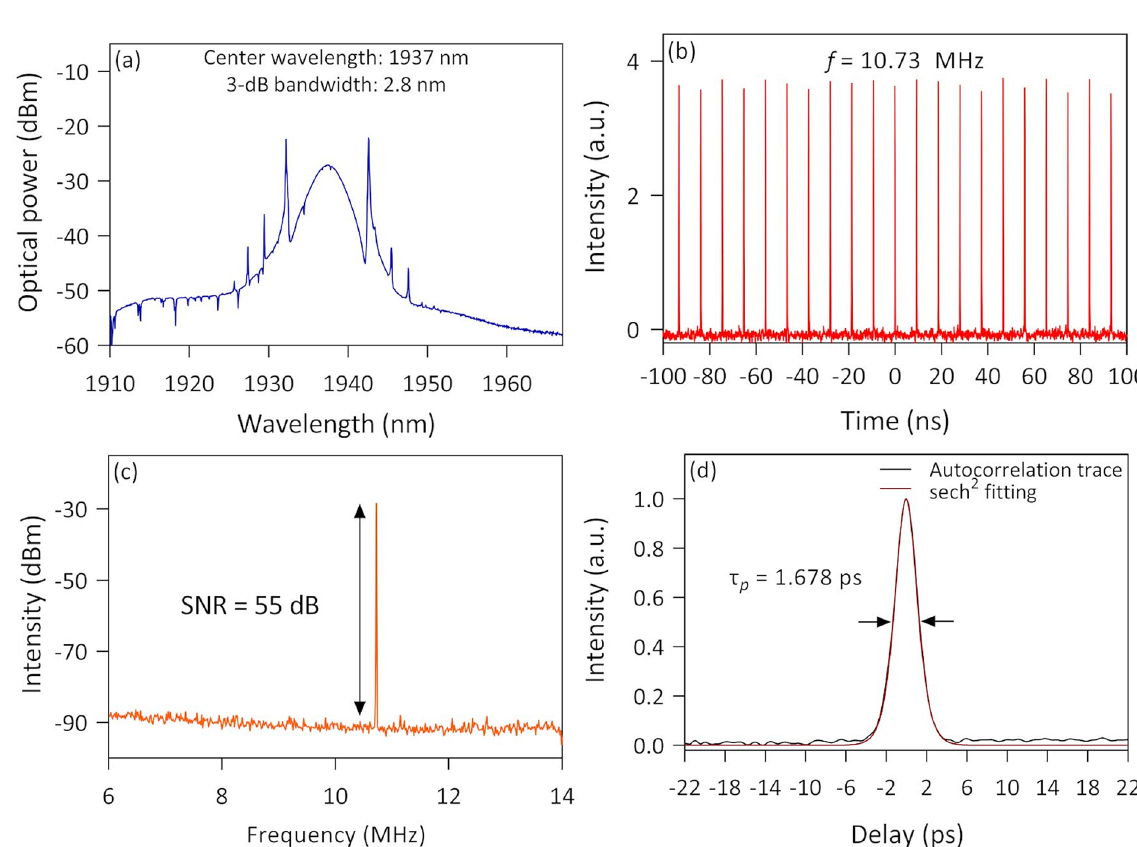
Figure 11. The output characteristic for mode-locked thulium-doped fiber laser using the Ta 2 AlC tapered fiber saturable absorber ( a ) optical spectrum, ( b ) pulse train, ( c ) radio frequency spectrum, and ( d ) autocorrelation